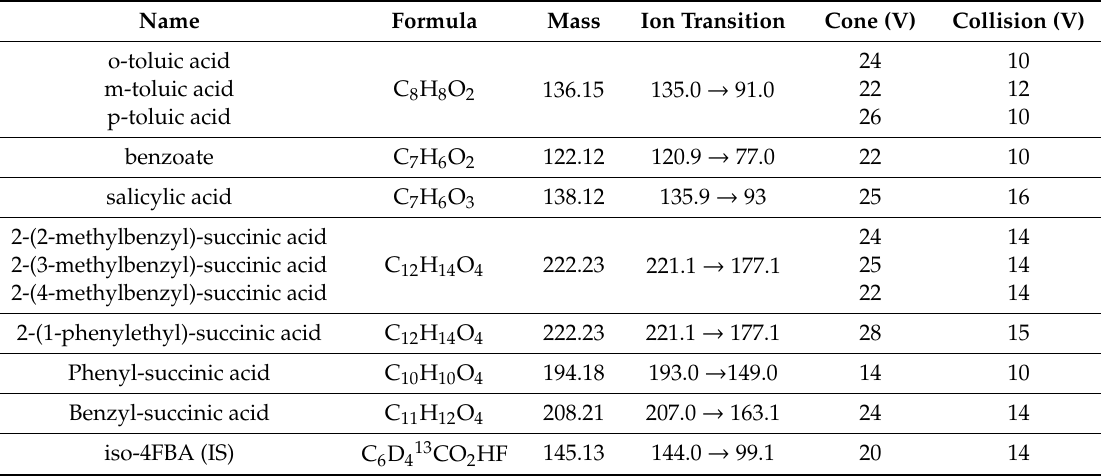
Table 1. MS / MS Measurement